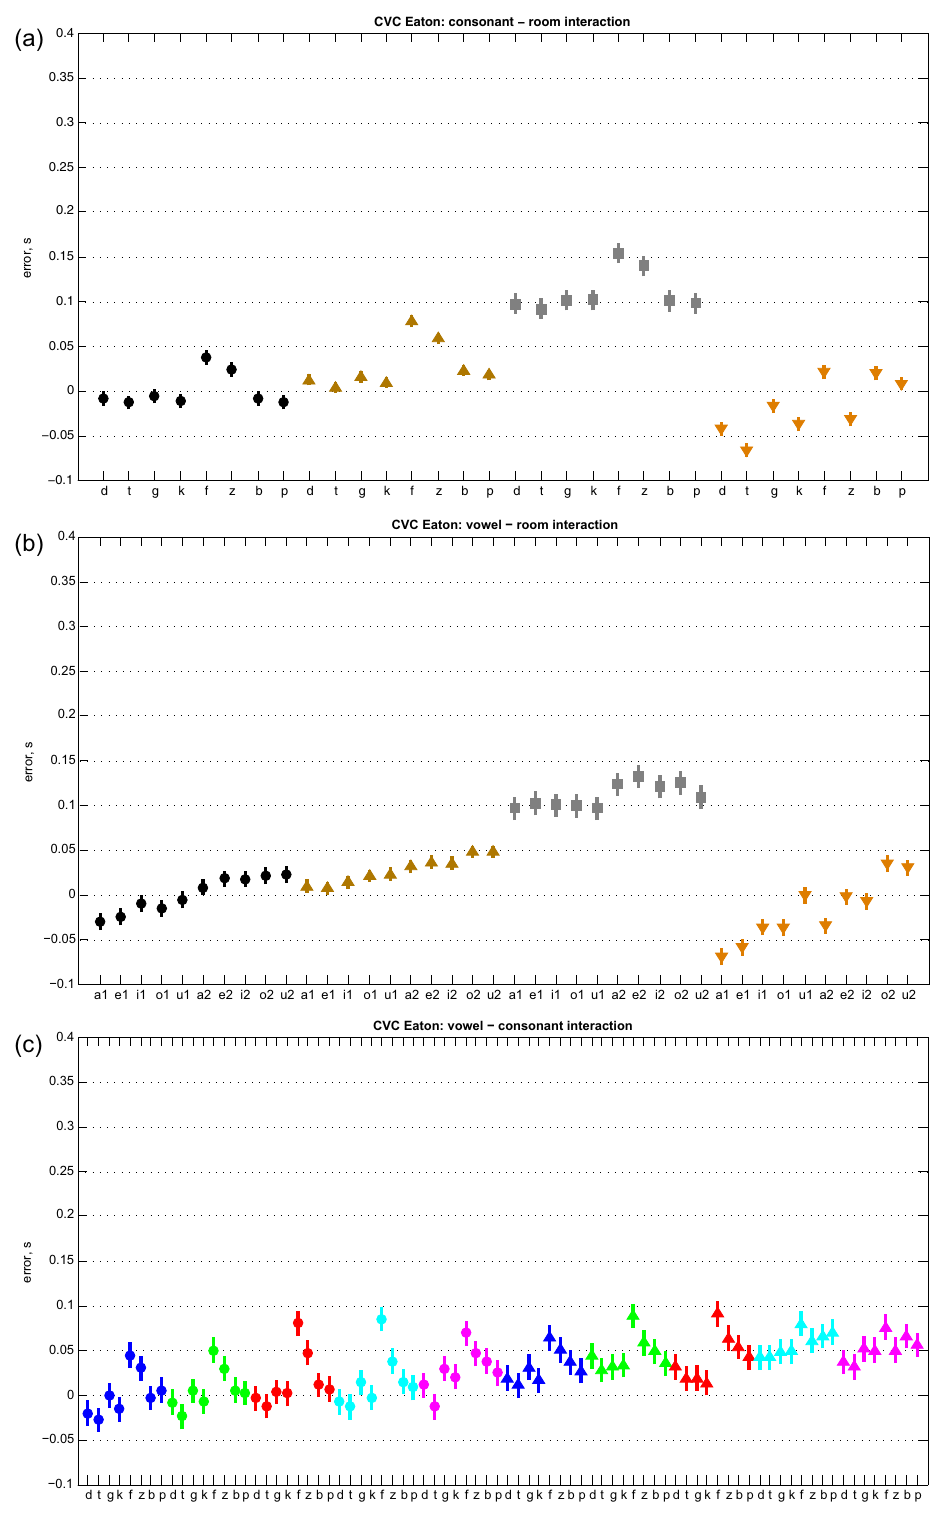
Figure 1. CVC logatomes: marginal means for Eaton ’ s algorithm. (a) “ Consonant ” (cid:5) “ room ” interaction, (b) “ vowel ” (cid:5) “ room ” interaction, (c) “ vowel ” (cid:5) “ consonant ” interaction. X -axis details: For the panels (a) and (c) left consonants of the CVCs are denoted on the x -axis. For the panel (b) vowel group V1 (/a/, / ɛ /, / ɪ /, /c/, / f /) as “ a1 ”–“ u1 ” and vowel group V2 (/a:/, /e/, /i/, /o/, /u/) as “ a2 ”–“ u2 ” . Symbols for the marginal means: For the panels (a) and (b) “ booth ” – circle, “ meeting ” – upward triangle, “ listening ” – square, “ of fi ce ” – downward triangle. For the panel (c) vowel group V1 (/a/, / ɛ /, / ɪ /, /c/, / f /) – circle and vowel group V2 (/a:/, /e/, /i/, /o/, /u/) – upward